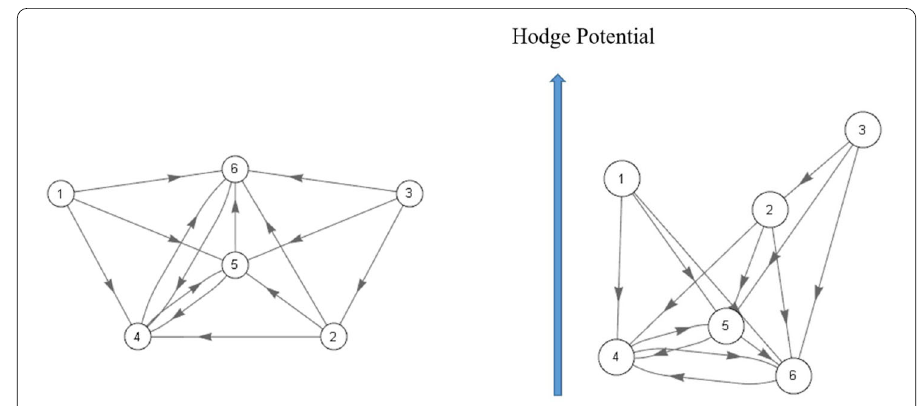
Figure B.3 A sample network. On the left-hand side is visualization by the charge-spring visualization and on the right-hand-side is the visualization of the same network with the horizontal coordinates determined by the Hodge potential and the horizontal coordinate determined by the spring-charge method